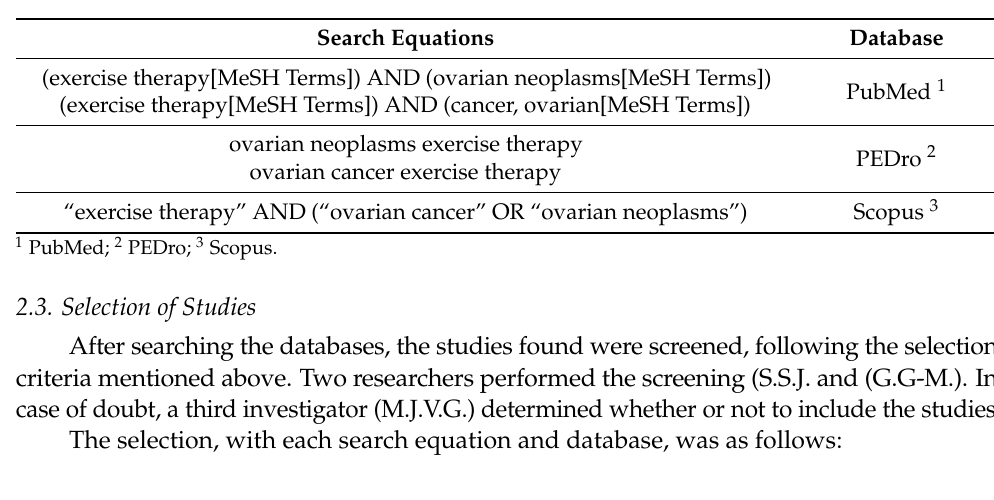
Table 1. Search equations in